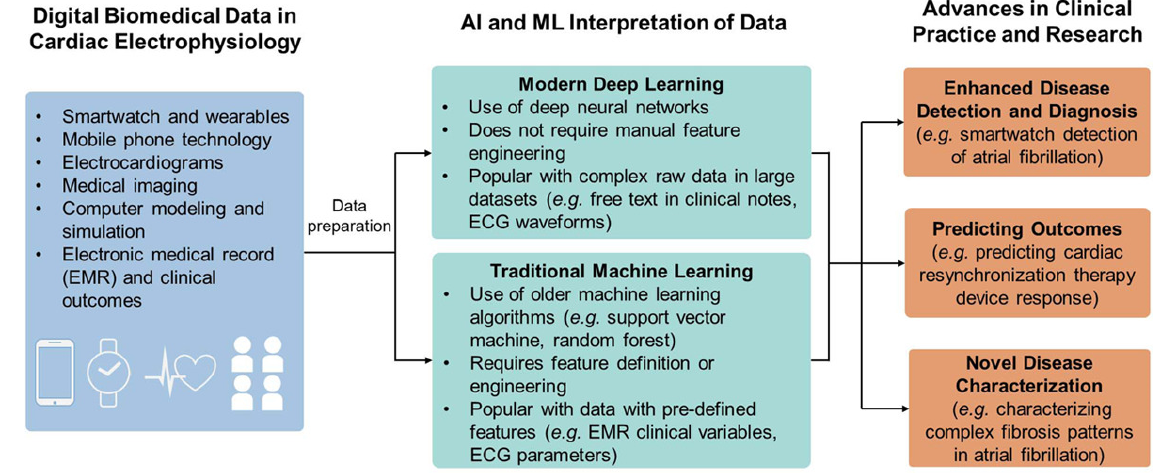
Figure 8. Role of AI/ML in cardiology. The biomedical data collected through cardiac electrophysiology measurement are interpreted through either traditional or modern ML algorithms for advancing the health outcome.